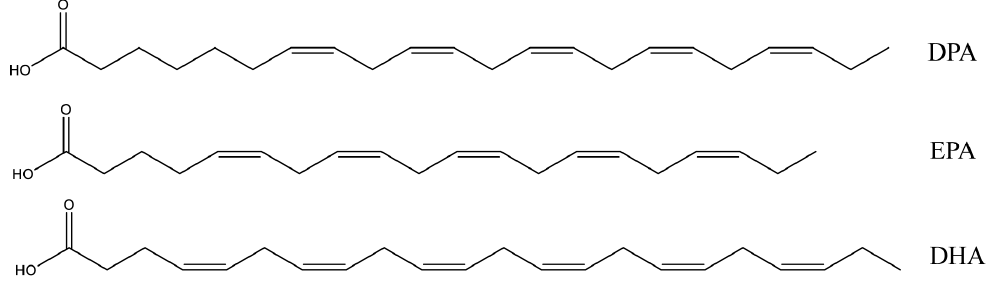
Figure 2. Structure of n - 3 docosapentaenoic acid (DPA), eicosapentaenoic acid (EPA), and docosahexaenoic acid